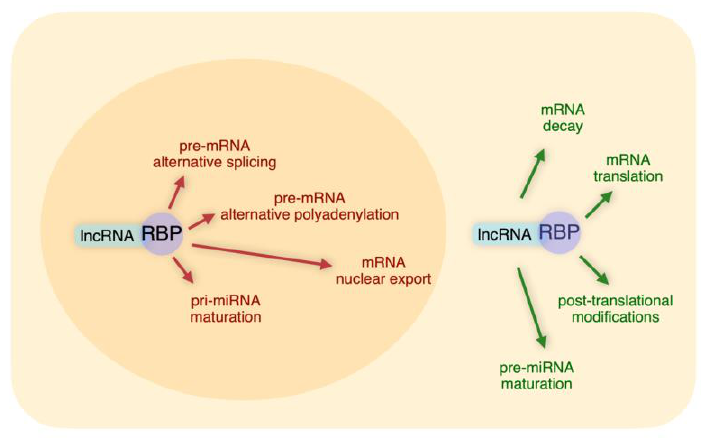
Figure 1. Nuclear and cytoplasmic functions of long non-coding RNA (lncRNA)-RNA binding protein (RBP) networks. Table 1. Summary of the lncRNA-RBP networks described in this review. The ENSEMBL accession number is provided in parentheses. In the case of Drosophila and C. Elegans lncRNAs, the accession numbers to FlyBase and WormBase, respectively, are provided in